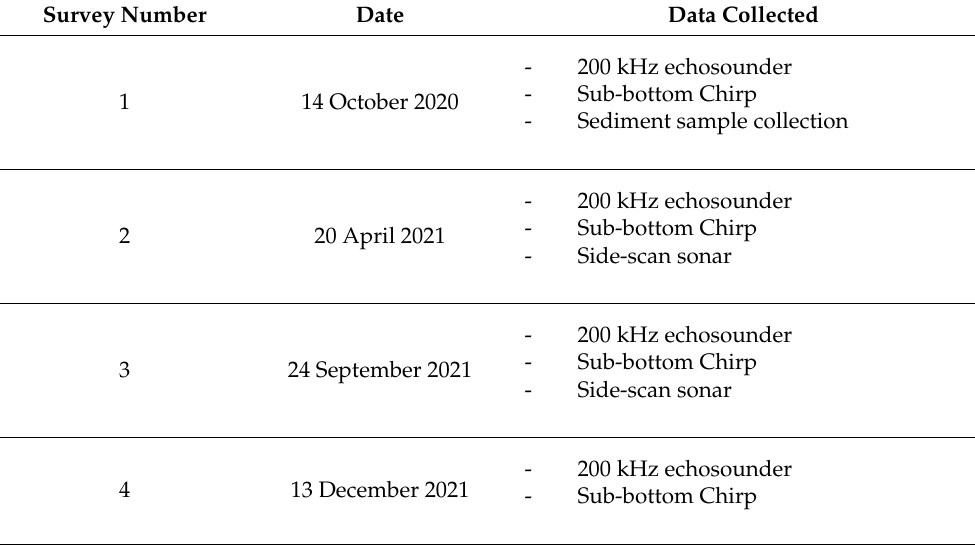
Table 1. List of surveys and instruments employed during the one-year experiment in the Lido di Dante study site. Survey Number